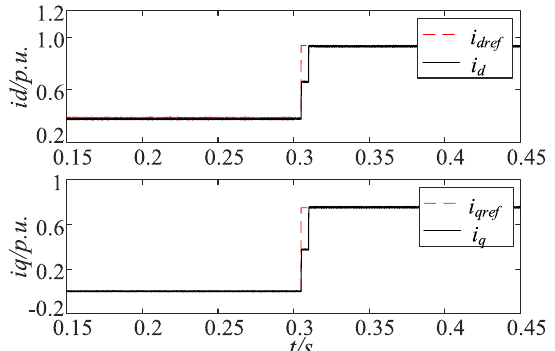
Fig. 12 dq -axis current when the voltage drops in the rectified state